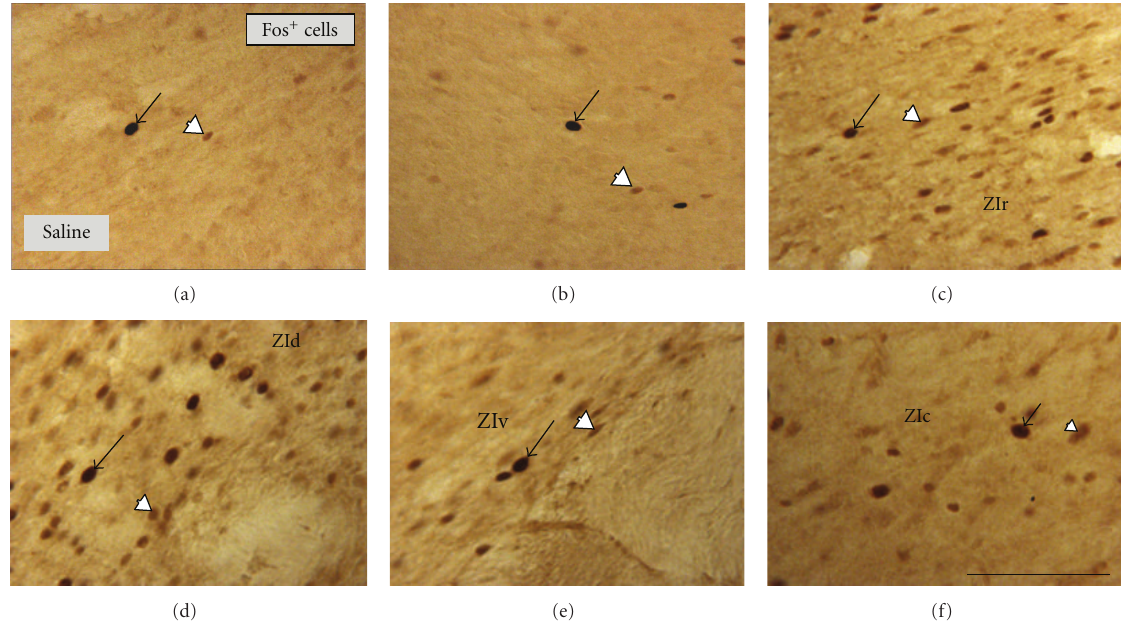
Figure 1: Fos + cells in the STN (central region) and in the di ff erent sectors of the ZI, namely, ZIr (a), ZId (b), ZIv (c), and ZIc (d). Fos immunoreactivity was apparent in cell nuclei; cells were either strongly (black arrows) or weakly immunostained (white arrowheads). All cases are from the saline group; patterns of immunostaining were similar in the other groups of both acute and chronic models. All figures are of coronal sections; dorsal to top and lateral to right. Scale bar = 100 µ